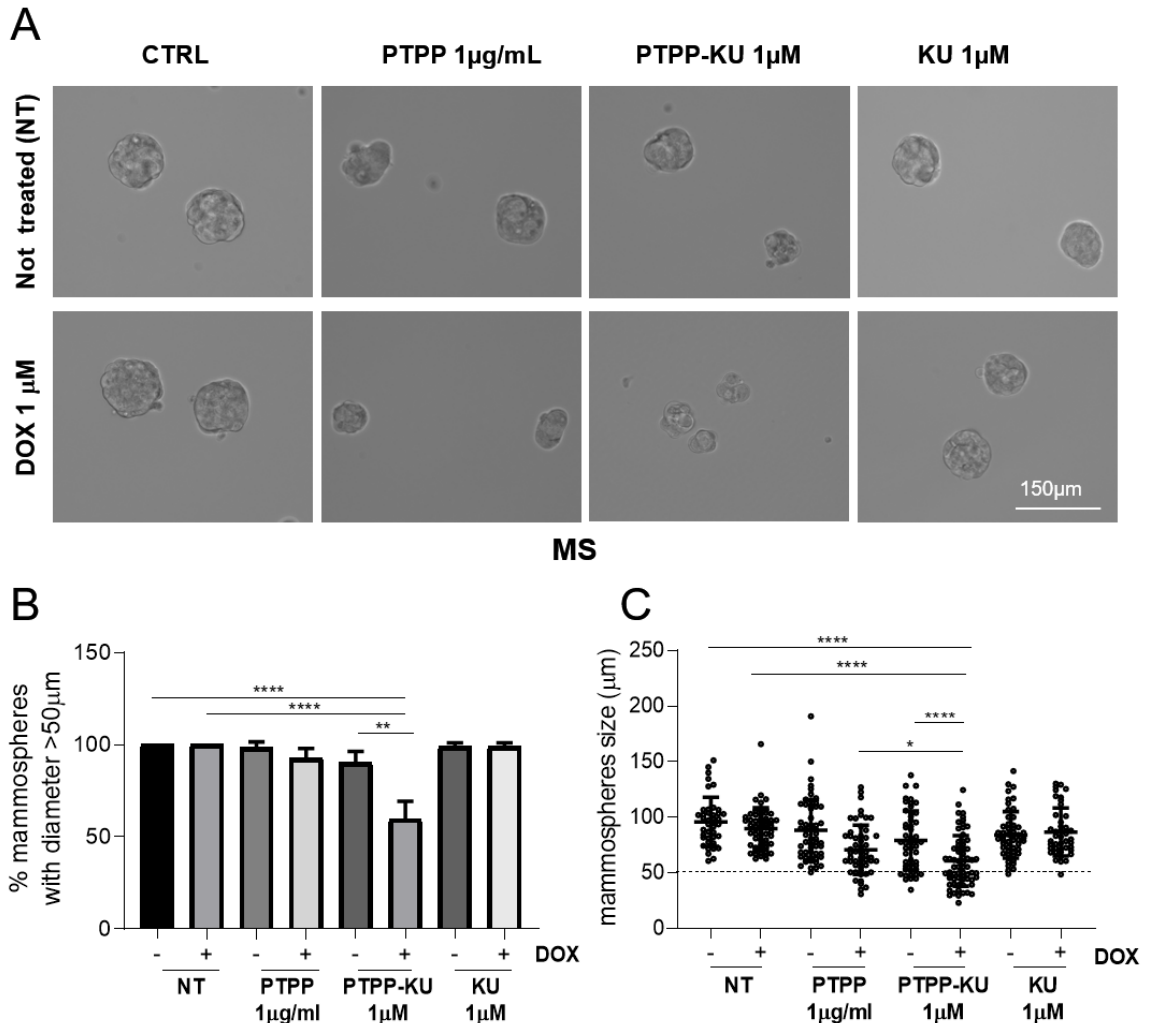
Figure 2. Reduction in mammosphere size caused by PTPP–KU after doxorubicin treatment compared with non-treated (NT) cells. ( A ) Optical microscopy images (20X) representative of the mammospheres’ morphology after treatment with 1 µ M of DOX for 3 h and free KU (1 µ M), PTPP–KU (1 µ M), and PTPP (1 µ g/mL), administered 30 min before adding DOX. Scale bar 150 µ m. ( B ) Graph representing the percentage of mammospheres (diameter > 50 µ m with rounded morphology) obtained from 5000 cells/mL in triplicate wells, with or without treatment. The results are expressed as the mean ± SD for at least three independent experiments and were analyzed using a Student’s t -test (* p < 0.05, ** p < 0.01, **** p < 0.0001; statistical analysis is not shown if it is not considered significant) ( n = 4). ( C ) Graph representing the mammosphere diameters after the treatments described in ( A ).